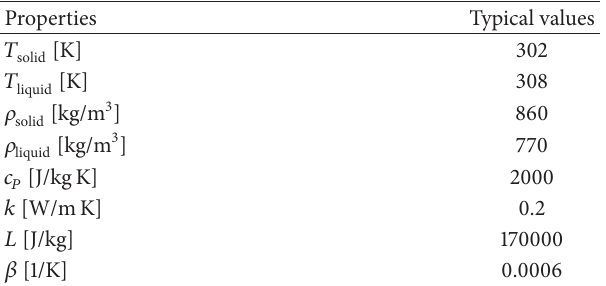
Table 1: Thermophysical properties of